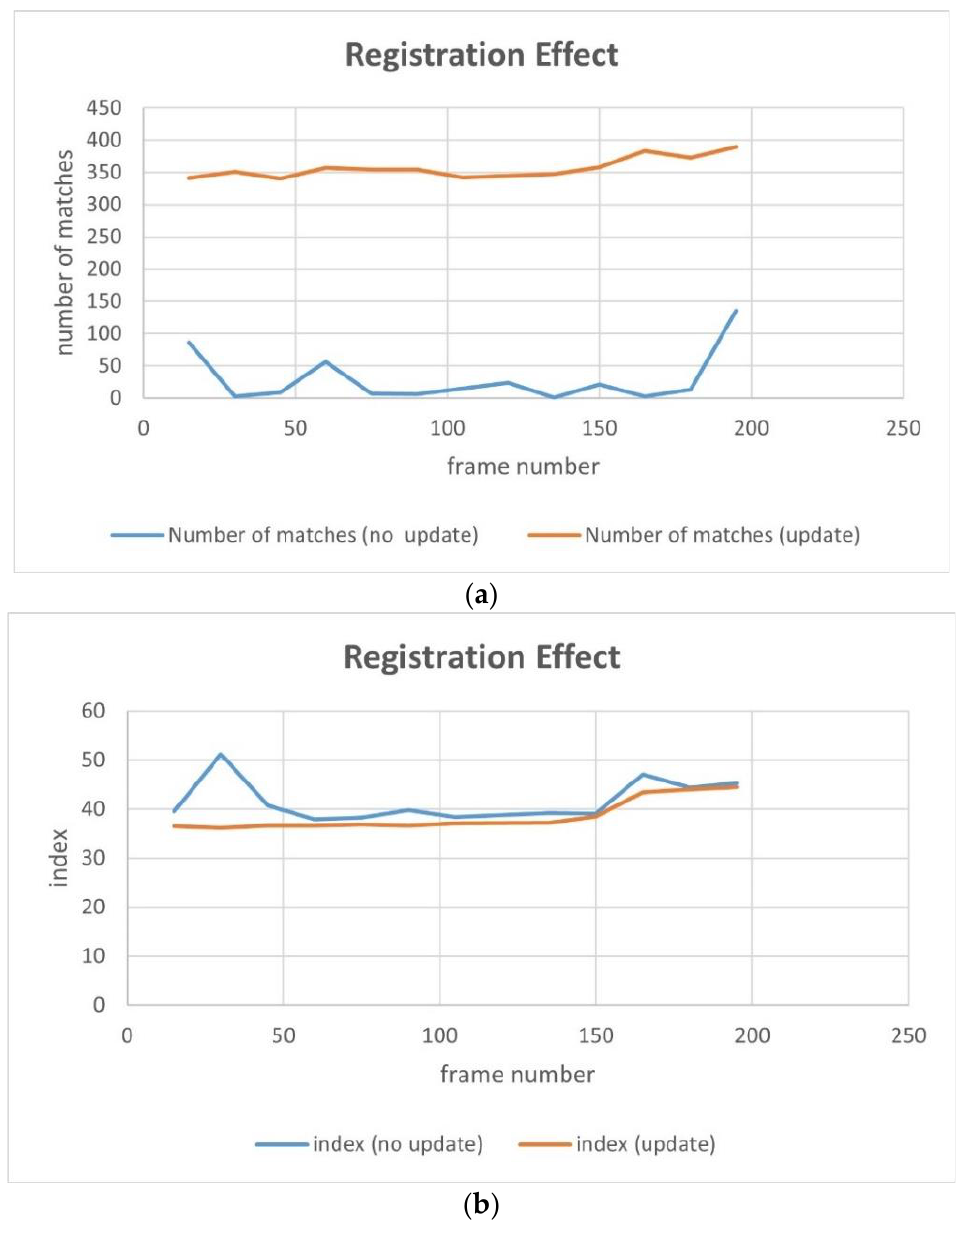
Figure 21. Comparison of the number of matching points and 𝑖𝑛𝑑𝑒𝑥 values: ( a ) number of matches; ( b ) average pixel value of the registered difference image ( 𝑖𝑛𝑑𝑒𝑥 ).